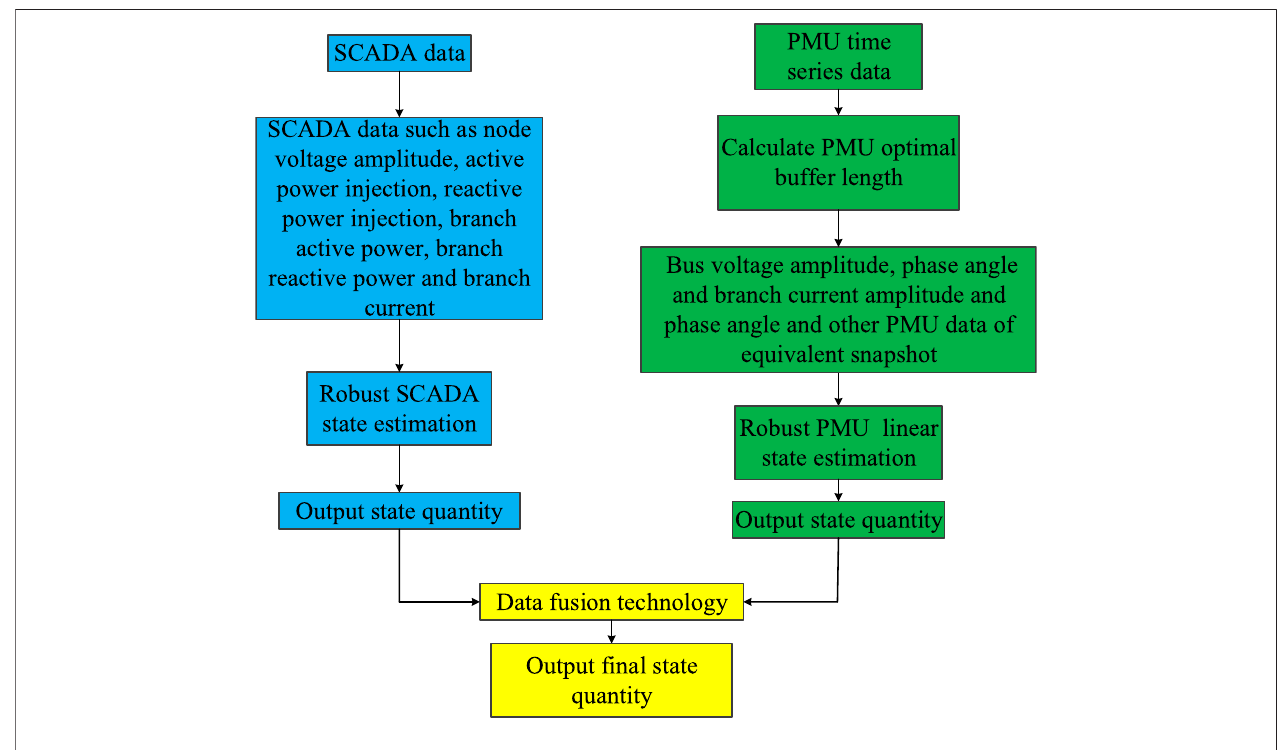
FIGURE 2 | Data fusion SE calculation fl owchart.